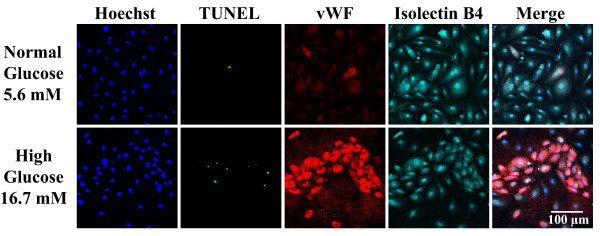
Effects of high glucose on expression of the inflammatory marker vWF and TUNEL staining-apoptosis in HCAECs. Cells were treated with 16.7 mM glucose for 24 h. Endothelial cell apoptosis was labeled by the TUNEL reaction (green). vWF (red) and isolectin B4 (turquoise) were visualized by fluorescence microscopy. Isolectin B4 was used as a marker for endothelial cells. Nuclei were counterstained with Hoechst (blue).